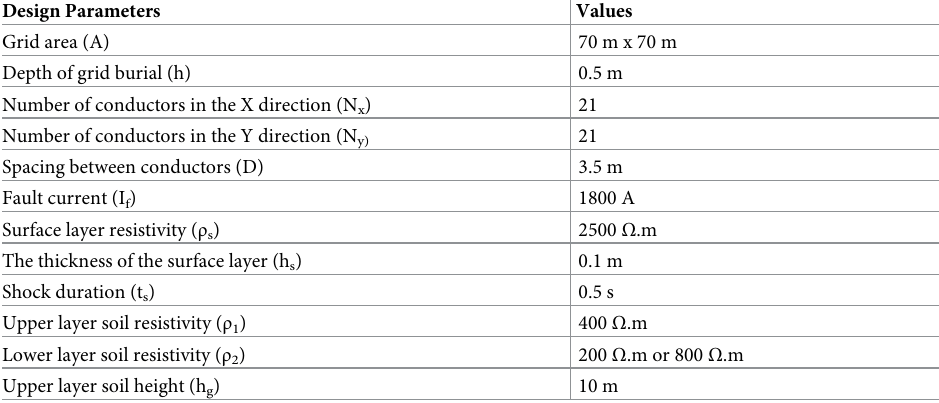
Table 14. Grounding system design input for horizontal two-layer soil structure [27].